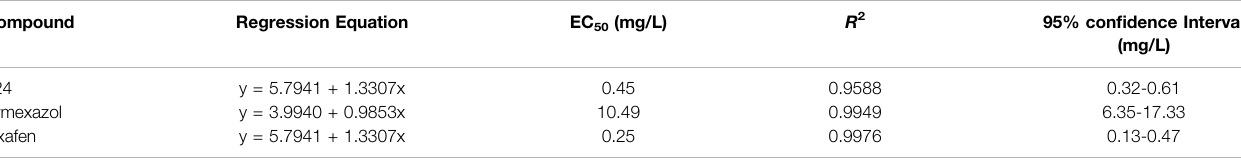
TABLE 2 | EC 50 values of T24 against R. solani.